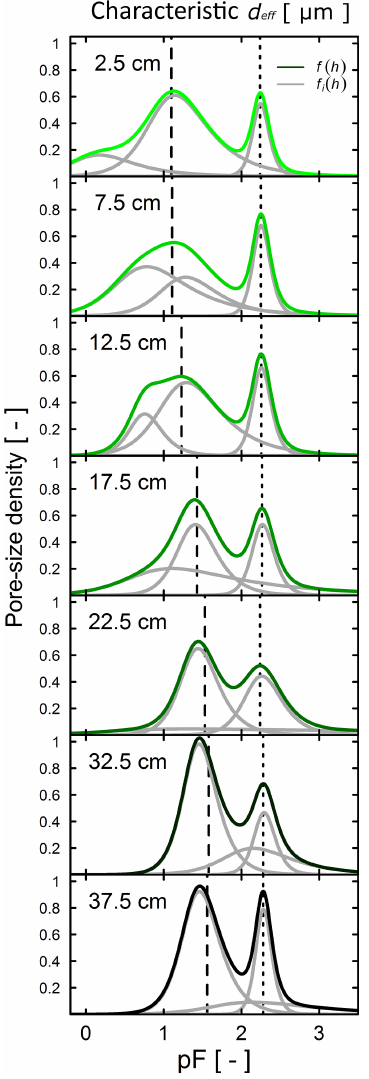
Figure 6. Continuous pore-size distributions calculated from Eq. (4) per depth showing the overlap of the three pore spaces. The dashed lines represent the median ( d 50 ) of the first and second pore do- mains, the increase of which positively correlates with increasing depth. The dotted lines mark the mode of the third modality which remains constant regardless of